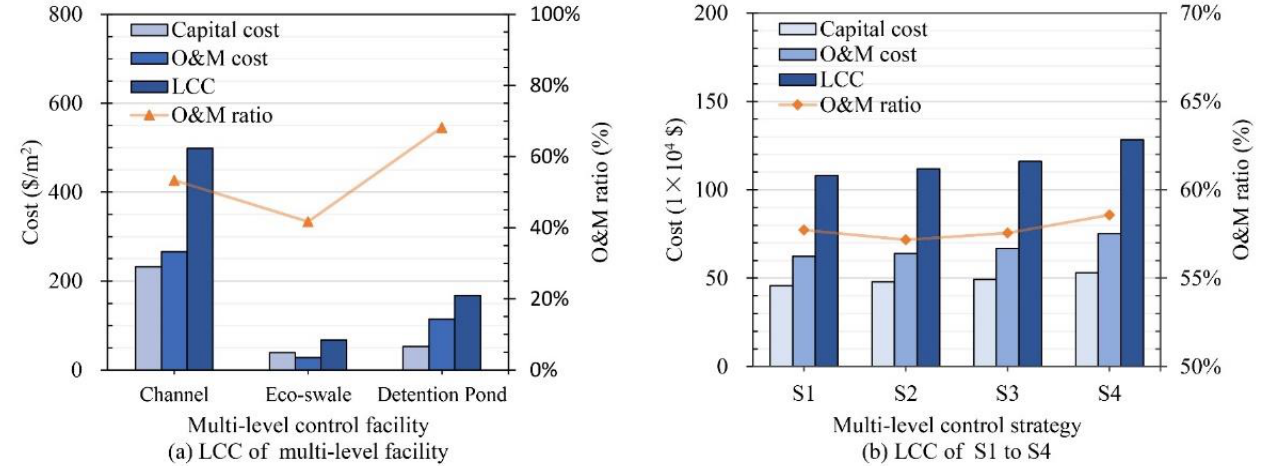
Figure 11. LCC of each multi-level facility ( a ) and multi-level control strategy ( b ).